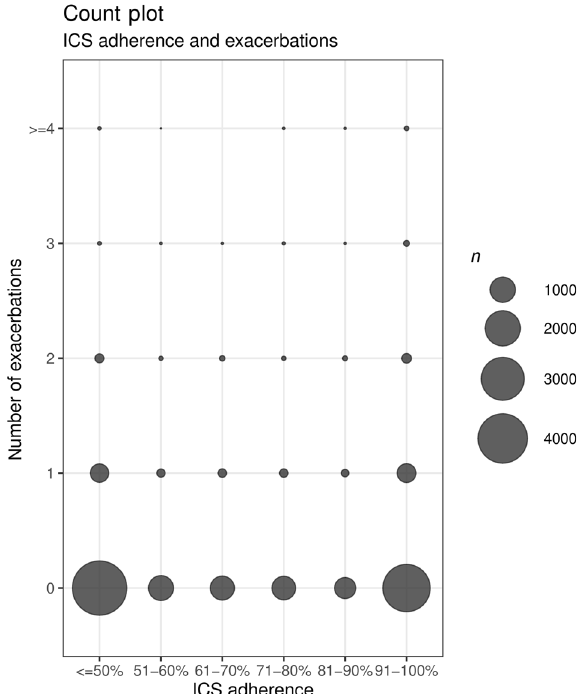
Fig. 3 Countplot in which the number of exacerbations, de fi ned as a short course of oral corticoid steroids (OCS), is shown per ICS adherence category for six categories.